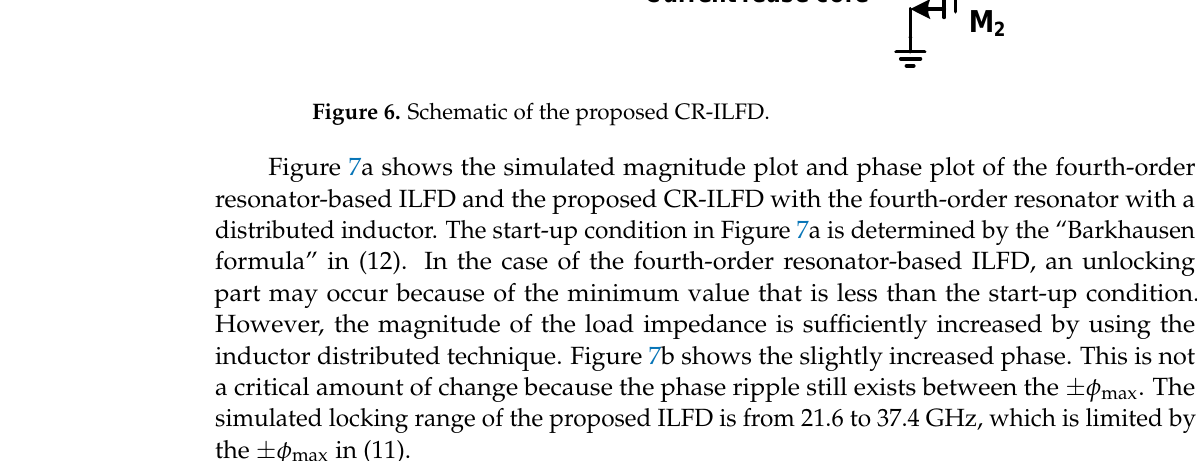
Figure 6. Schematic of the proposed CR-ILFD.